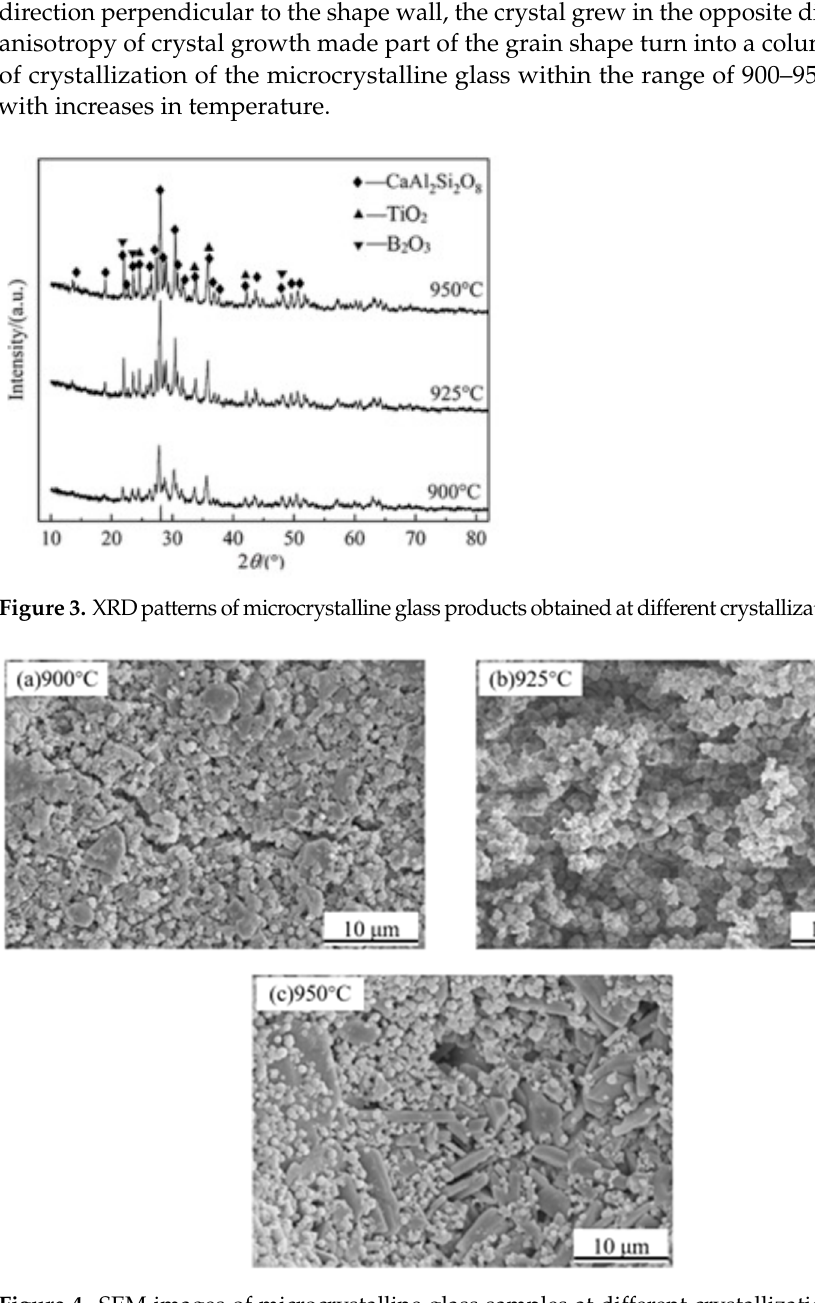
Figure 5. Effects of crystallization temperature on the density of the microcrystalline glass. Water absorption is a physical quantity that indicates the degree of water absorption of an object. A low water absorption rate could inhibit the adsorption of a leaching solution into the inte- rior of a curing body, thus inhibiting the leaching of heavy metals. Therefore, reducing the water absorption rate of microcrystalline glass is important for product quality improvement. Figure 6 illustrates the results of the effect of crystallization temperature on the water absorption of the stud- ied microcrystalline glass. The trend of the water absorption of the microcrystalline glass with the increase in the crystallization temperature and the trend of density with the increase in the temper- ature were opposite. This may be attributed to the increase in the number of crystalline phases pre- cipitated from the microcrystalline glass with increasing temperature. Moreover, the crystalline grains primarily had spherical and columnar shapes; therefore, the number of pores between the crystals gradually decreased and the densities of the crystals increased. As displayed in Figure 4, with the increase in the crystallization temperature, the number of crystalline phases gradually in- creased, the densities of the crystalline phases increased, and the water absorption rate of the mi- crocrystalline glass decreased.